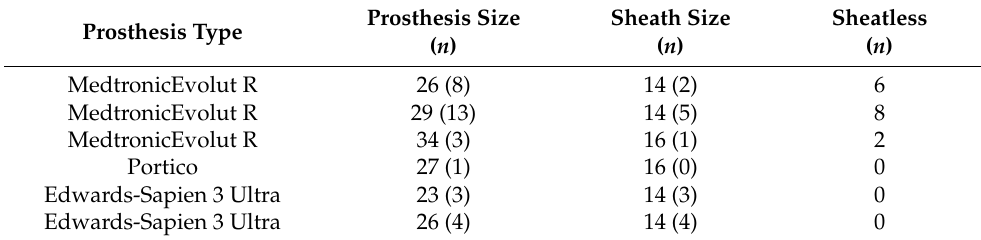
Table 3. Characteristics of the valve prostheses.